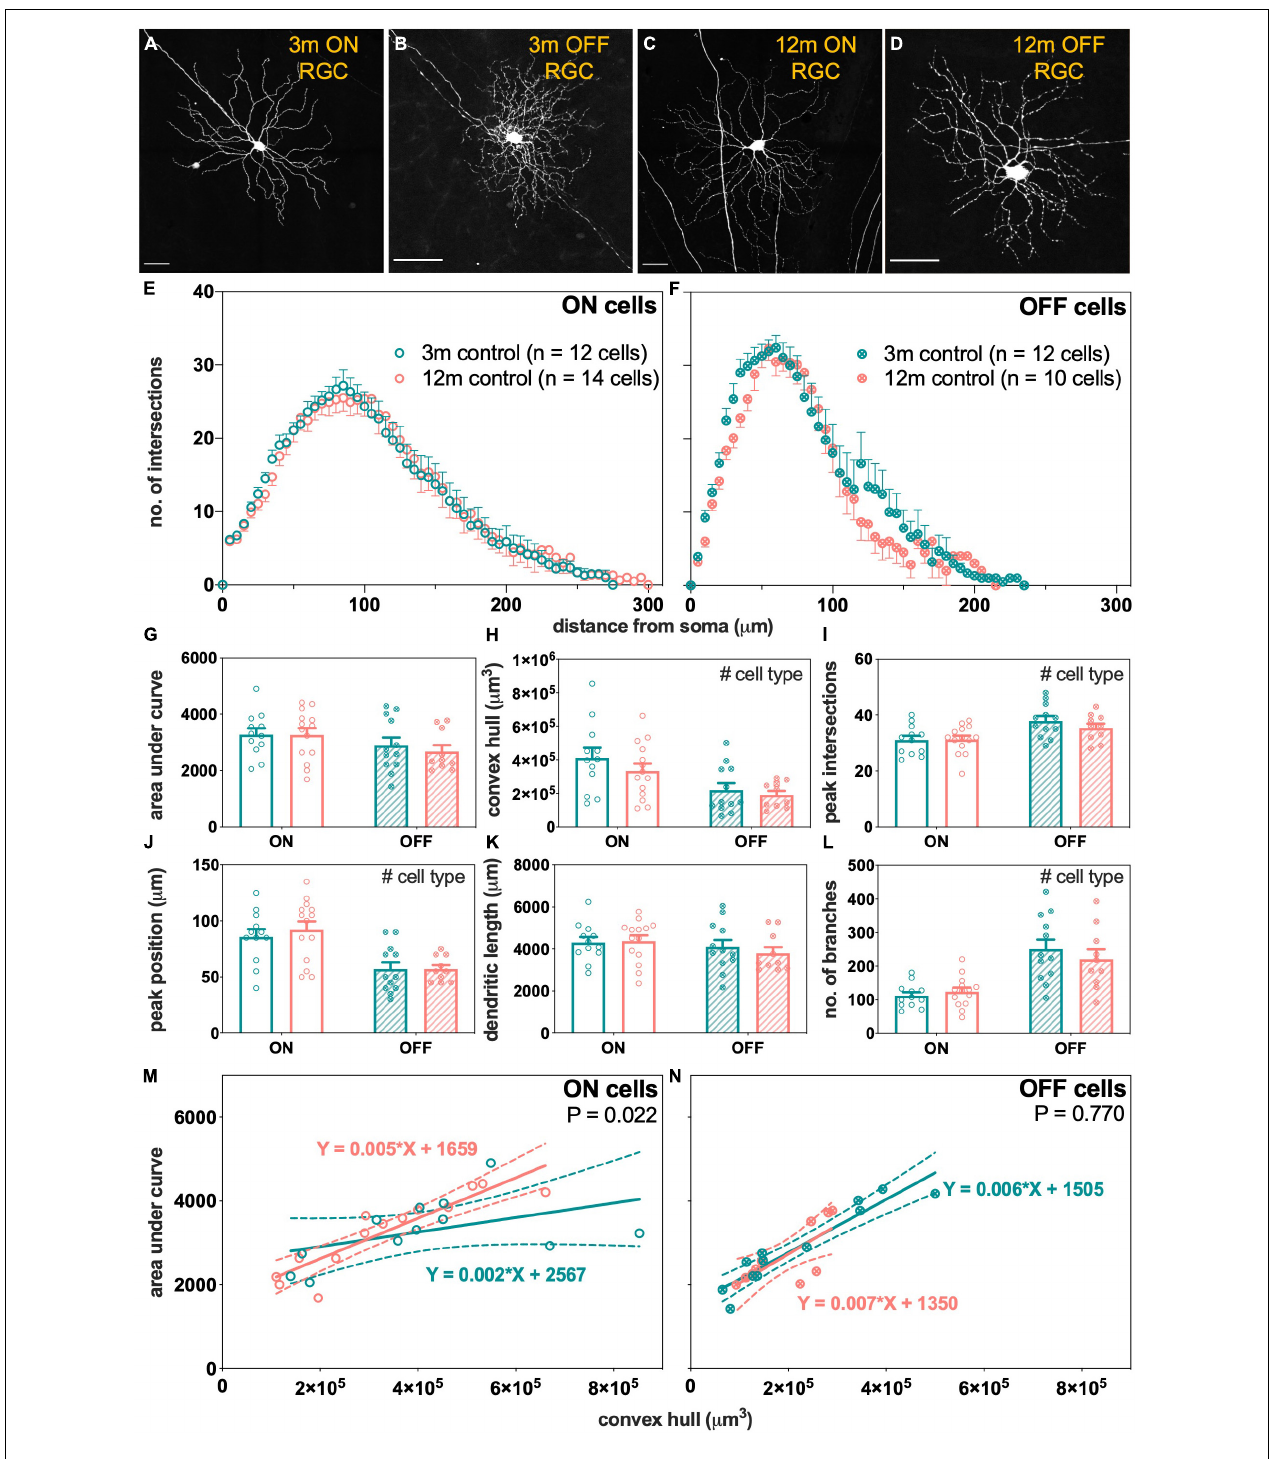
FIGURE 5 | Morphological assessment of ON and OFF RGCs in 3- and 12-month-old control eyes. (A–D) Maximum intensity projections of confocal image z-stacks displaying dendritic arbors of representative ON and OFF RGCs in 3- and 12-month-old mice. Scale bars , 50 µ m. (E,F) Sholl profiles showing group averaged dendritic complexity (no. of intersections) relative to distance from soma in (E) ON [3 m, teal, n = 12 cells (4 animals); 12 m, orange, n = 14 cells (3 animals)] and (F) OFF [3 m, teal, n = 12 cells (4 animals); 12 m, orange, n = 10 cells (4 animals)] RGCs. (G) Area under curve for ON (unfilled bars) and OFF (patterned bars) of 3-month-old (teal) and 12-month-old (orange) RGCs. (H) Convex hull volume. (I) Peak number of intersections. (J) Peak position. (K) Total dendritic length. (L) Total number of branches. (M,N) Dendritic complexity (area under curve) with respect to cell size (convex hull volume) in (M) ON and (N) OFF RGCs. Error bars, SEM; #, mixed effects model p < 0.05; solid line, linear regression; dashed line, 95% confidence interval; p -value, statistical significance of difference in slopes.